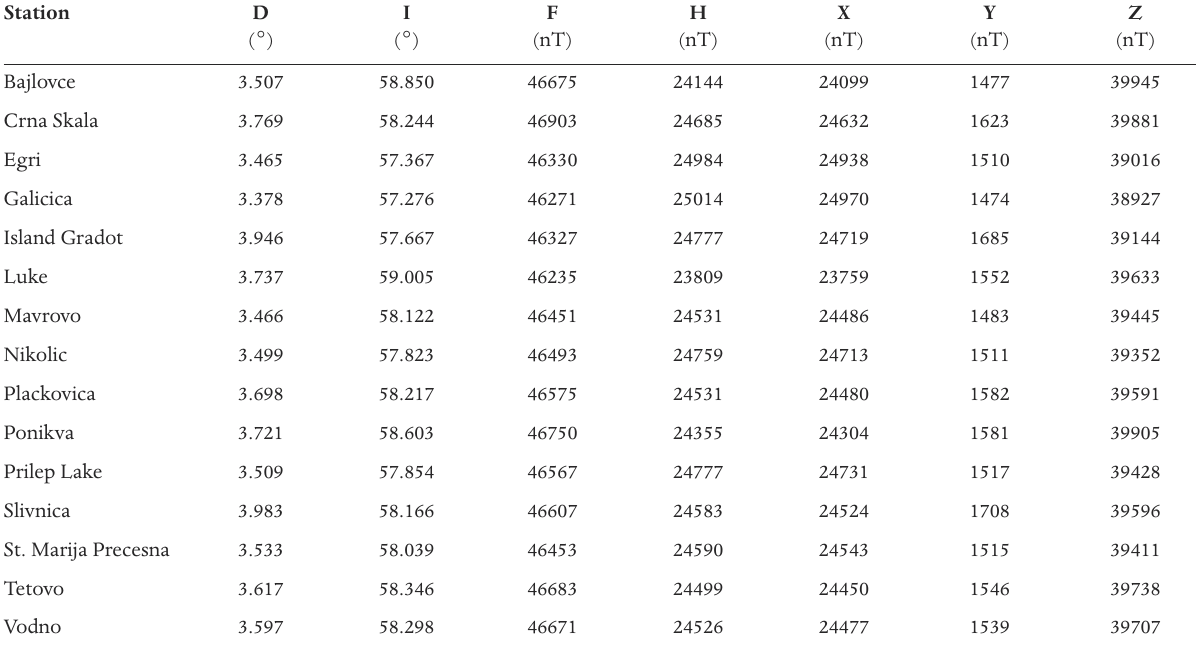
Table 2. Reduced measurements for the epoch 2010.5. D, declination; I, Inclination; T, Total intensity; H, Horizontal component; X, East component; Y, North component; Z, vertical component.